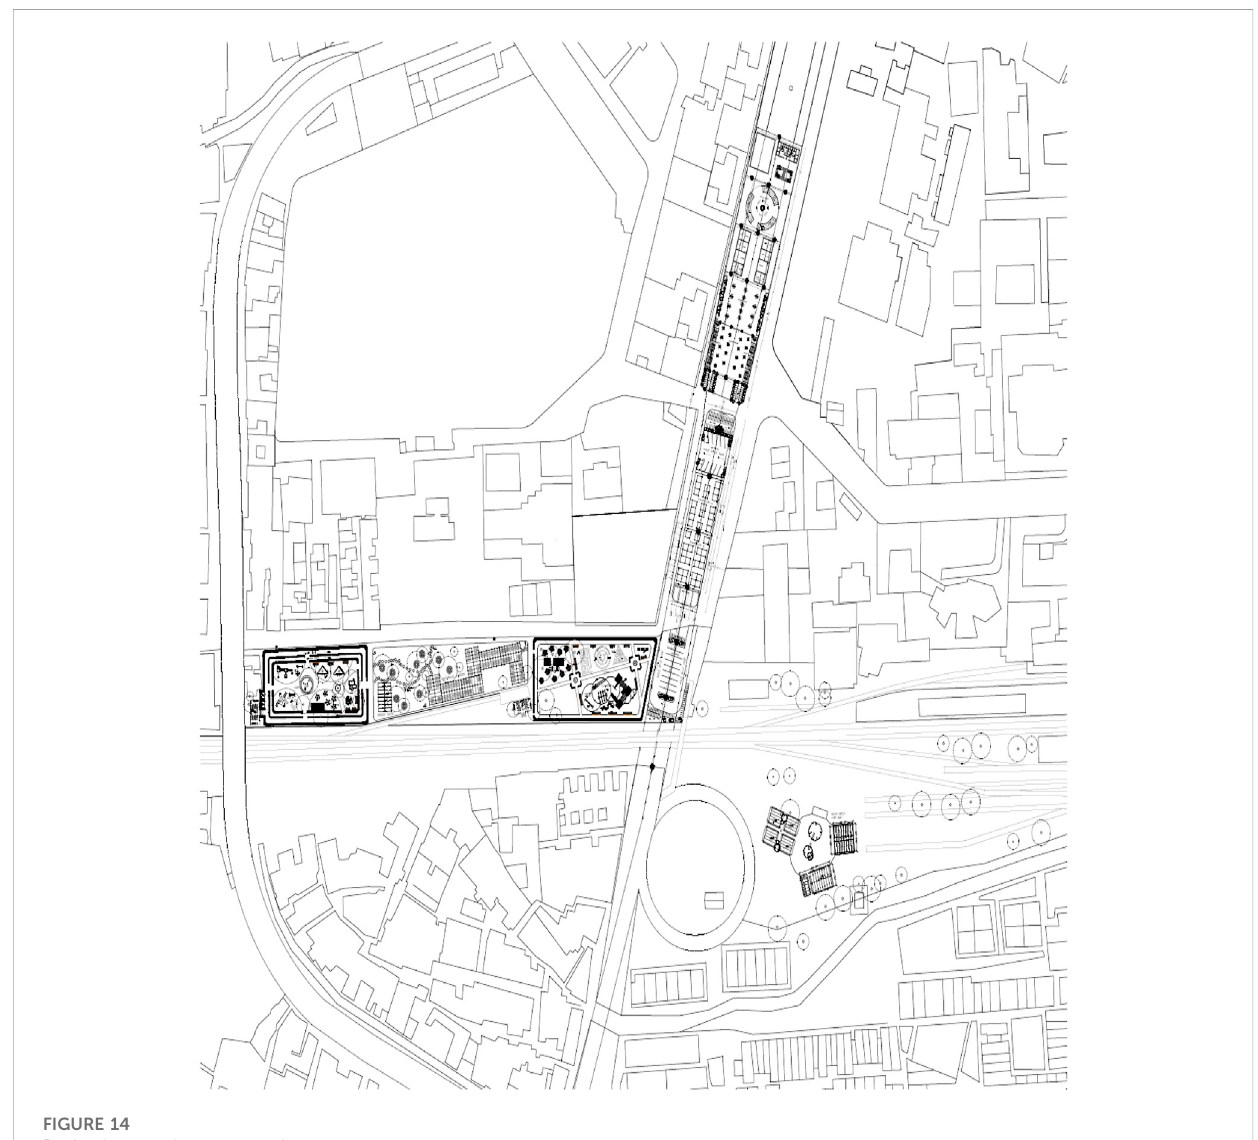
FIGURE 14 Design interventions master